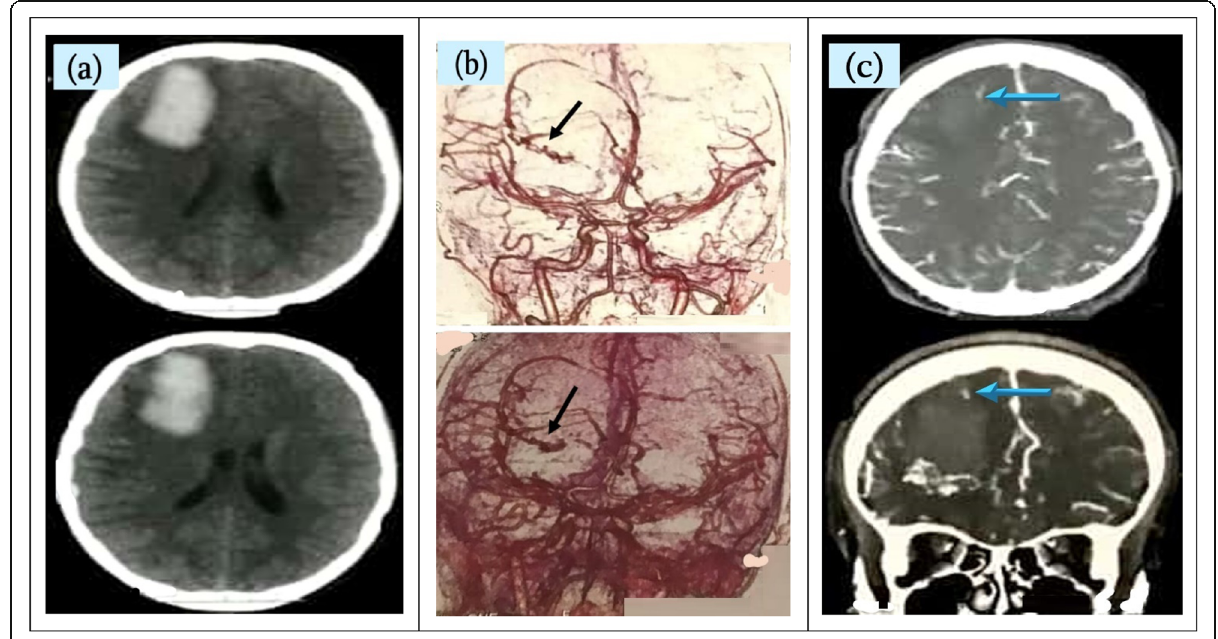
Fig. 3 An included patient presented by sudden onset of severe frontal headache, repeated vomiting and focal fits; a Initial non-contrast CT shows right frontal hematoma, b CT angiography shows AVM nidus (arrow), c The CT angiography shows spot sign detected in both axial and coronal sections (arrow)